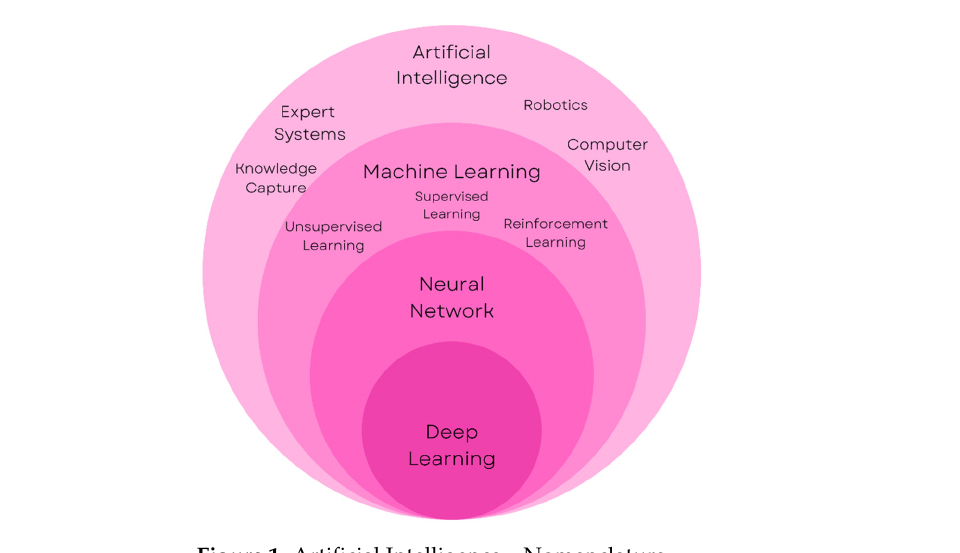
Figure 1. Artificial Intelligence—Nomenclature.